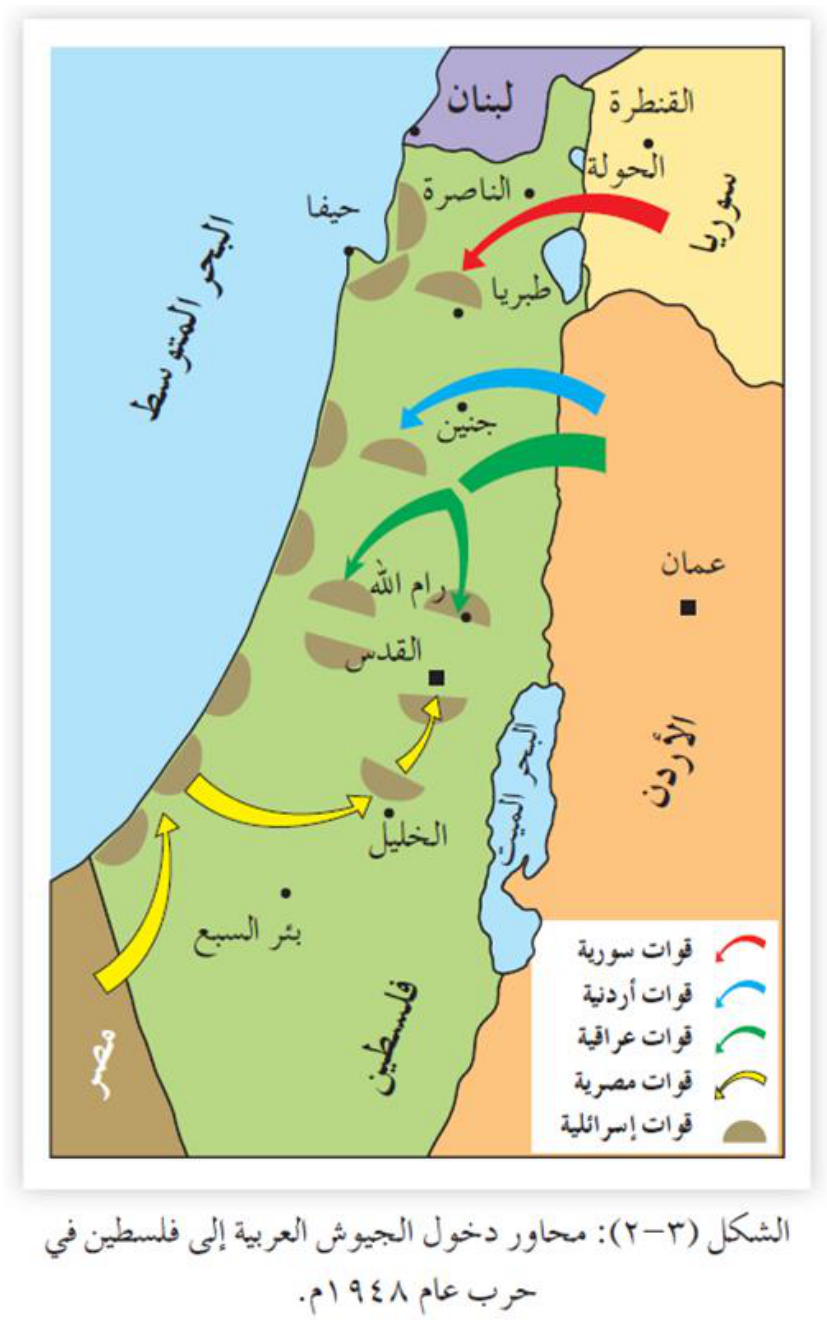
Image 2-3: Axes of Arab Armies Entering Palestine in the 1948 War [Legend:] Syrian forces (red), Jordanian forces (blue), Iraqi forces (green), Egyptian forces (yellow), Israeli forces